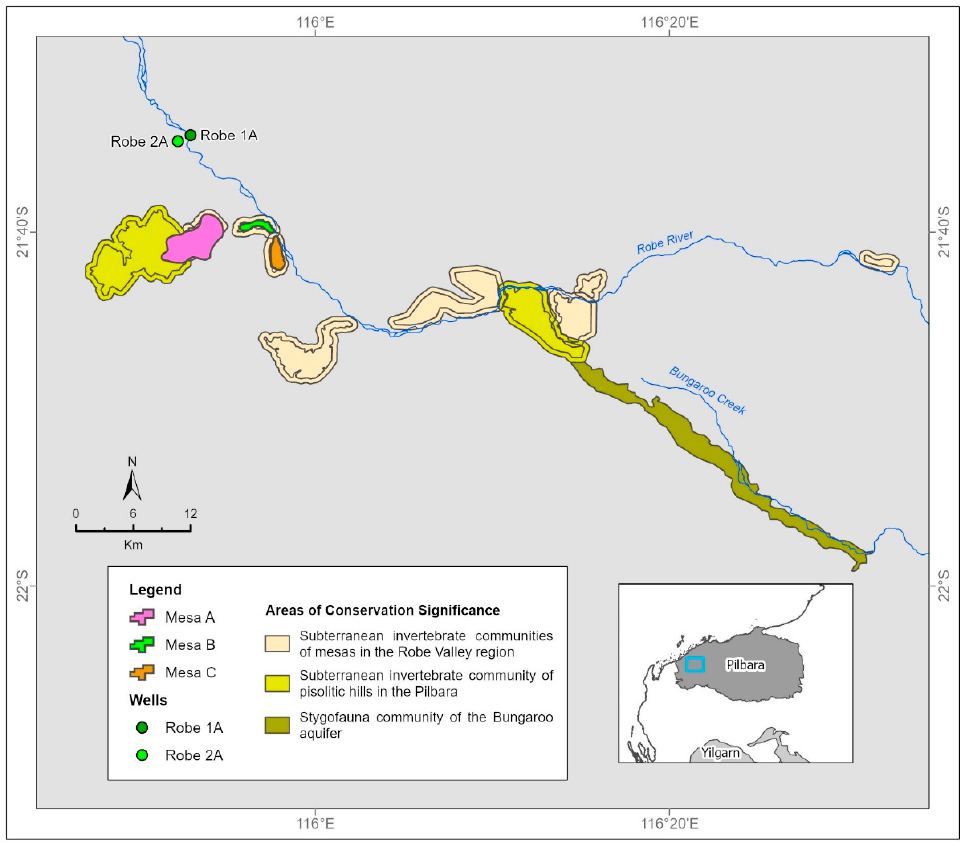
Figure 2. Components of the Robe Valley subterranean fauna hotspot.